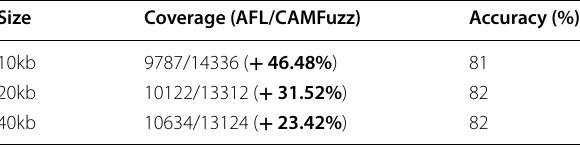
Table 6 The impact on different seeds